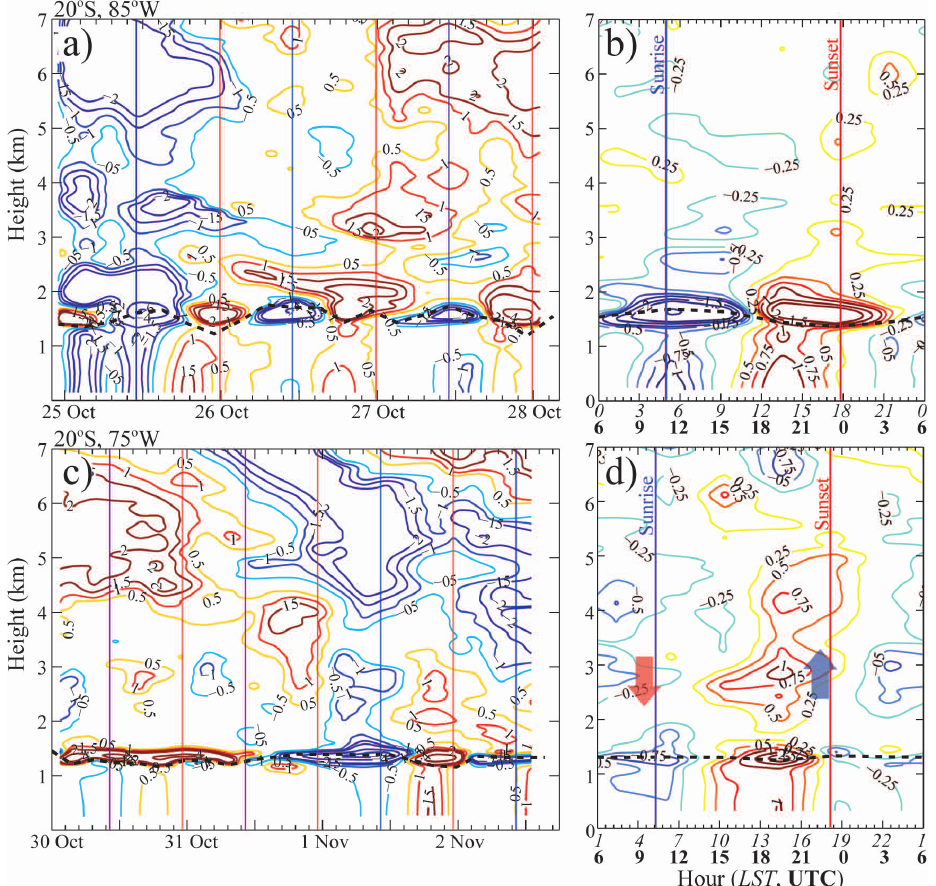
Fig. 12. Observed potential temperature anomalies from the mean state taken from R/V Ron Brown soundings during the stationary periods at 20 ◦ S, 85 ◦ W (upper panels) and 20 ◦ S, 75 ◦ W (lower panels). The anomalies are shown as a time series ( a and c ) and as an average diurnal anomaly ( b and d ). MBL depth is indicated by bold dashed line. Blue and red vertical lines indicate local sunrise and sunset, respectively. Arrows indicate vertical motion inferred from the WRF